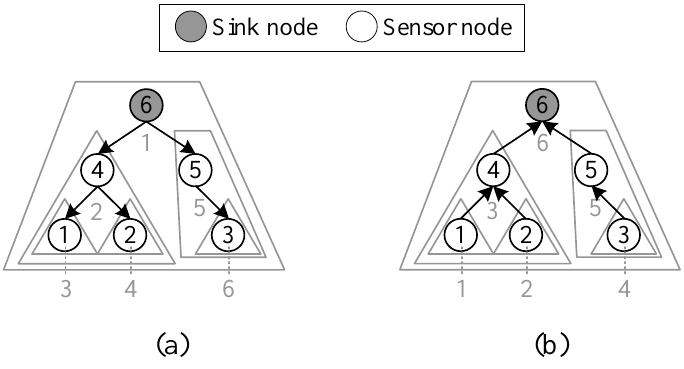
Figure 1. Scheduling sequence in W-MAC: (a) control packet delivery and (b) data packet